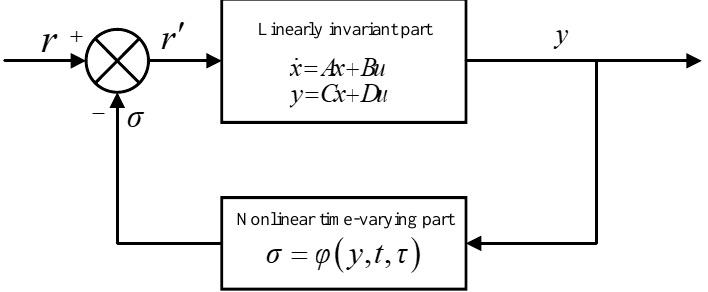
Figure 2. Structural block diagram of Popov hyper stability theory.